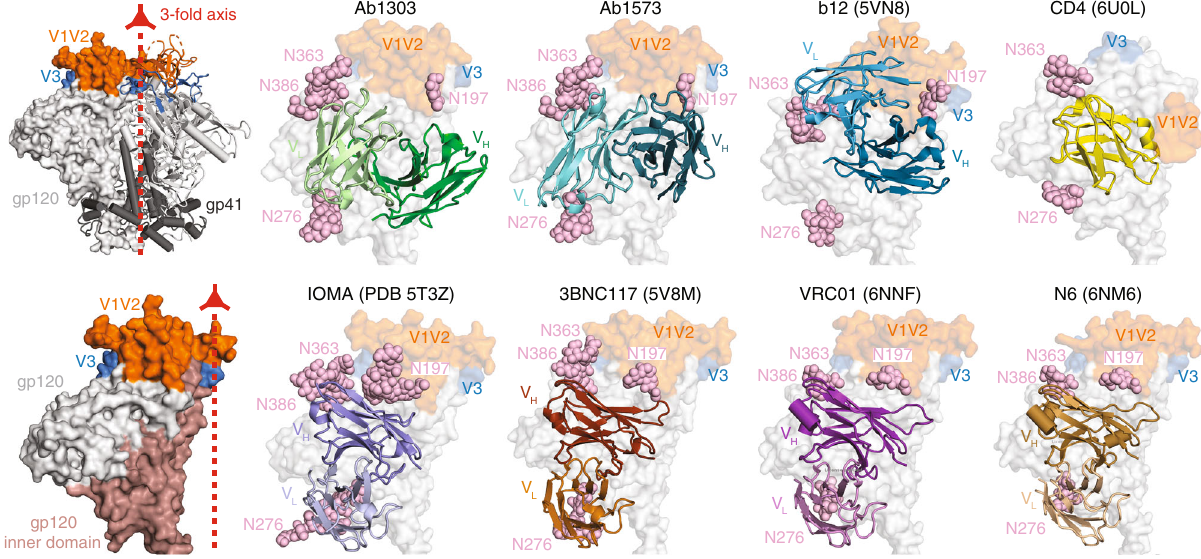
Fig. 4 Differences in antibody-binding poses for CD4bs bNAbs compared with CD4. Upper and lower left: surface representation of HIV-1 Env trimer (top) and gp120 monomer (bottom) showing locations of the threefold axis relating Env protomers (red arrow), the gp120 inner domain, V1V2, V3, and gp41. Remaining panels: Cartoon diagrams of V H -VL domains of the indicated bNAbs bound to HIV-1 gp120 (gray surface, pink spheres for N -linked glycans, V1V2 in orange, V3 in blue). PDB codes: Ab1303 and Ab1573 (this study), b12 (5VN8), CD4 (6U0L), IOMA (5T3Z), 3BNC117 (5V8M), a VRC01 derivative (6NNF), and an N6 derivative (6NM6). The V1V2 and V3 regions were largely disordered in the CD4-bound Env structure (PDB